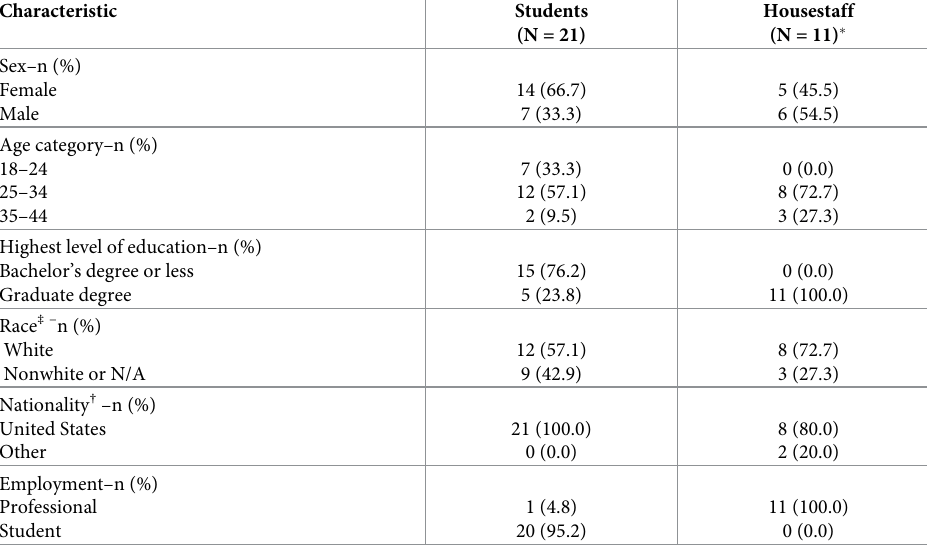
Table 1. Baseline characteristics of study